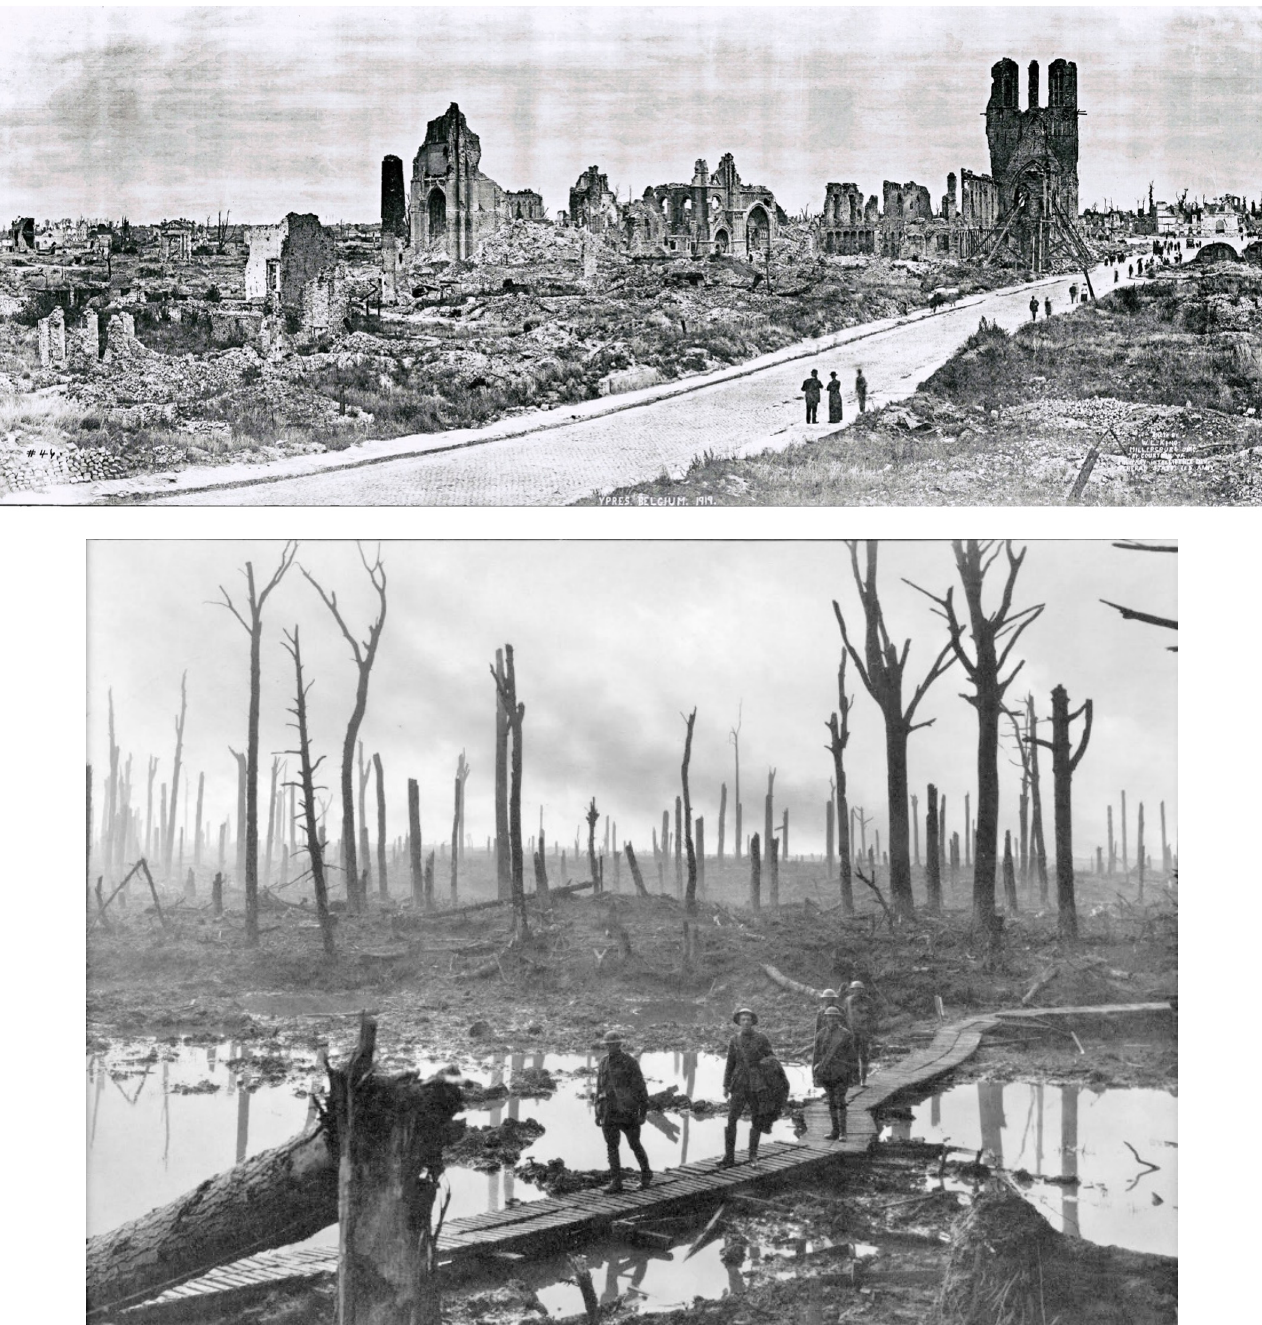
Figure 3. Devastation of both cultural and urban landscapes in Ypres after World War I. Picture bottom Frank Hurley, Public domain, via Wikimedia Commons.